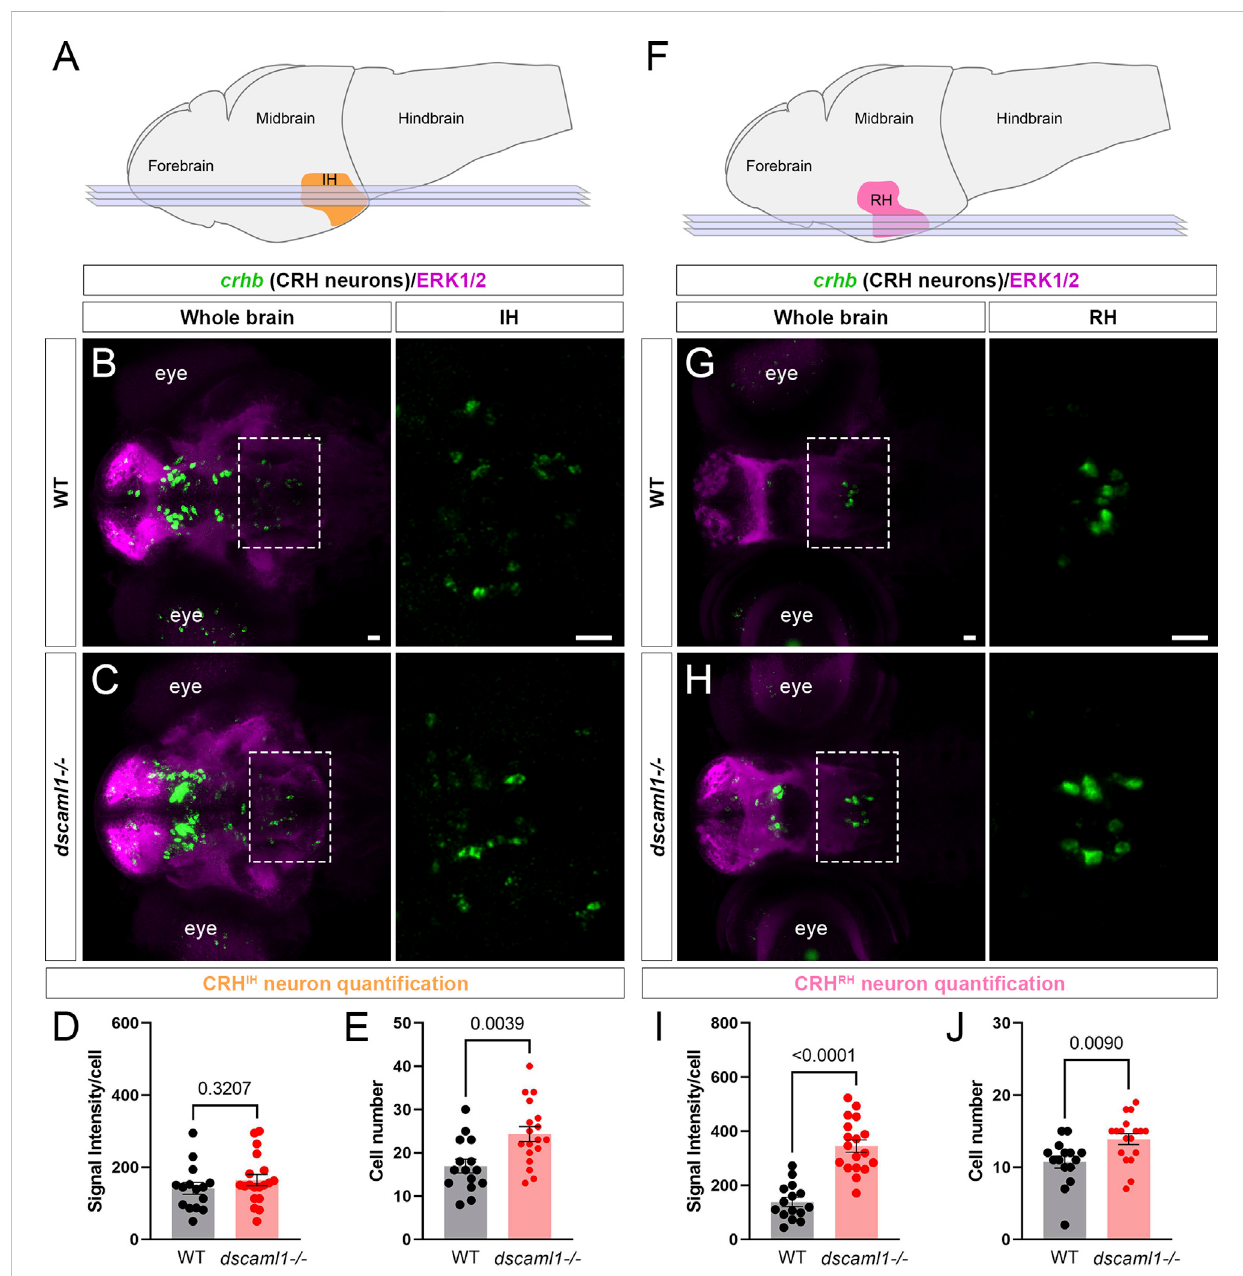
dscaml1 de fi ciency alters the development of CRH neurons in the intermediate and rostral hypothalamus. (A) Illustration of the larval brain, with the IH highlighted in orange. Imaging planes used for CRH IH neuron analysis are shown (light blue planes). (B, C) Labeling of CRH IH neurons by crhb FISH (green)andco-stainedwithanti-ERK1/2(magenta).Representativeconfocalsub-stackscontainingtheIHareshown,withtheIH(boxedregion)enlarged and shown in the right panel without the ERK1/2 co-stain. WT brain is shown in panel B and dscaml1 − / − brain is shown in panel C . (D – E) Quanti fi cationofthesignalintensitypercell (D) andcellnumber (E) . (F) Illustrationofthelarvalbrain,withtheRHhighlightedinpink.Imagingplanesused for CRH RH neuron analysis are shown (light blue planes). (G – H) Labeling of CRH RH neurons by crhb FISH (green) and co-stained with anti-ERK1/2 (magenta). Representative confocal sub-stacks containing the RH are shown, with the RH (boxed region) enlarged and shown in the right panel